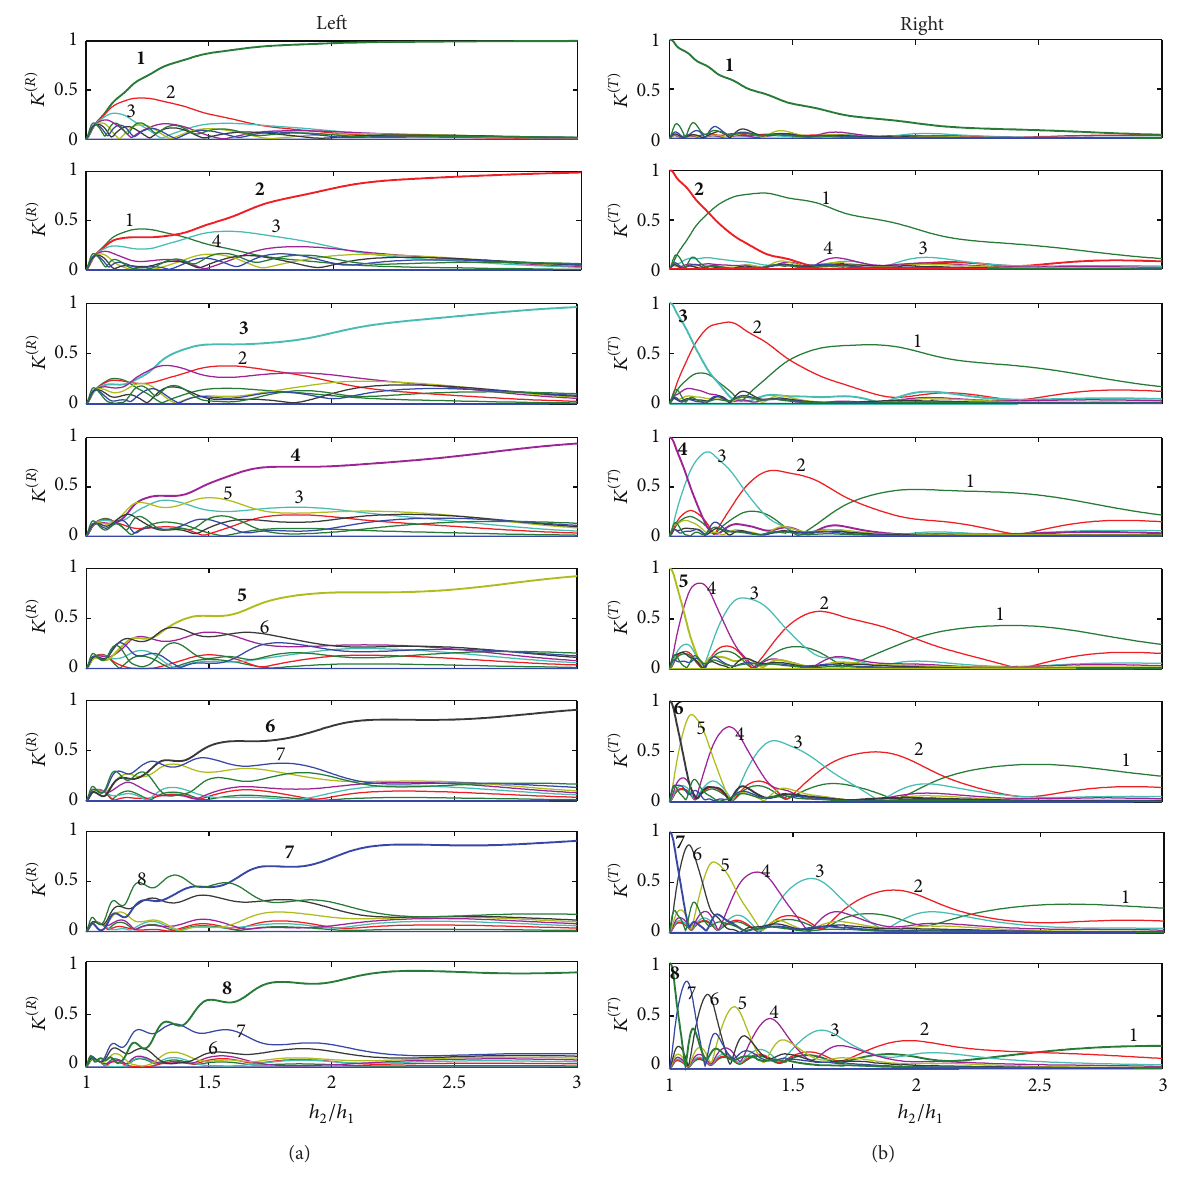
Figure 2: Reflection and transmission of amplitude coefficients on the left ( 𝐾 (𝑅) ) and right ( 𝐾 (𝑇) ) sides of a rectangular trench as function of the trench depth ℎ 2 /ℎ 1 . The ocean depth on the two sides of the trench is ℎ 1 = ℎ 3 = 4000 m. In each subplot, the bold number indicates the mode of incidence ̂𝚤 . The calculation error, err ̂𝚤 ≪ 10 −14